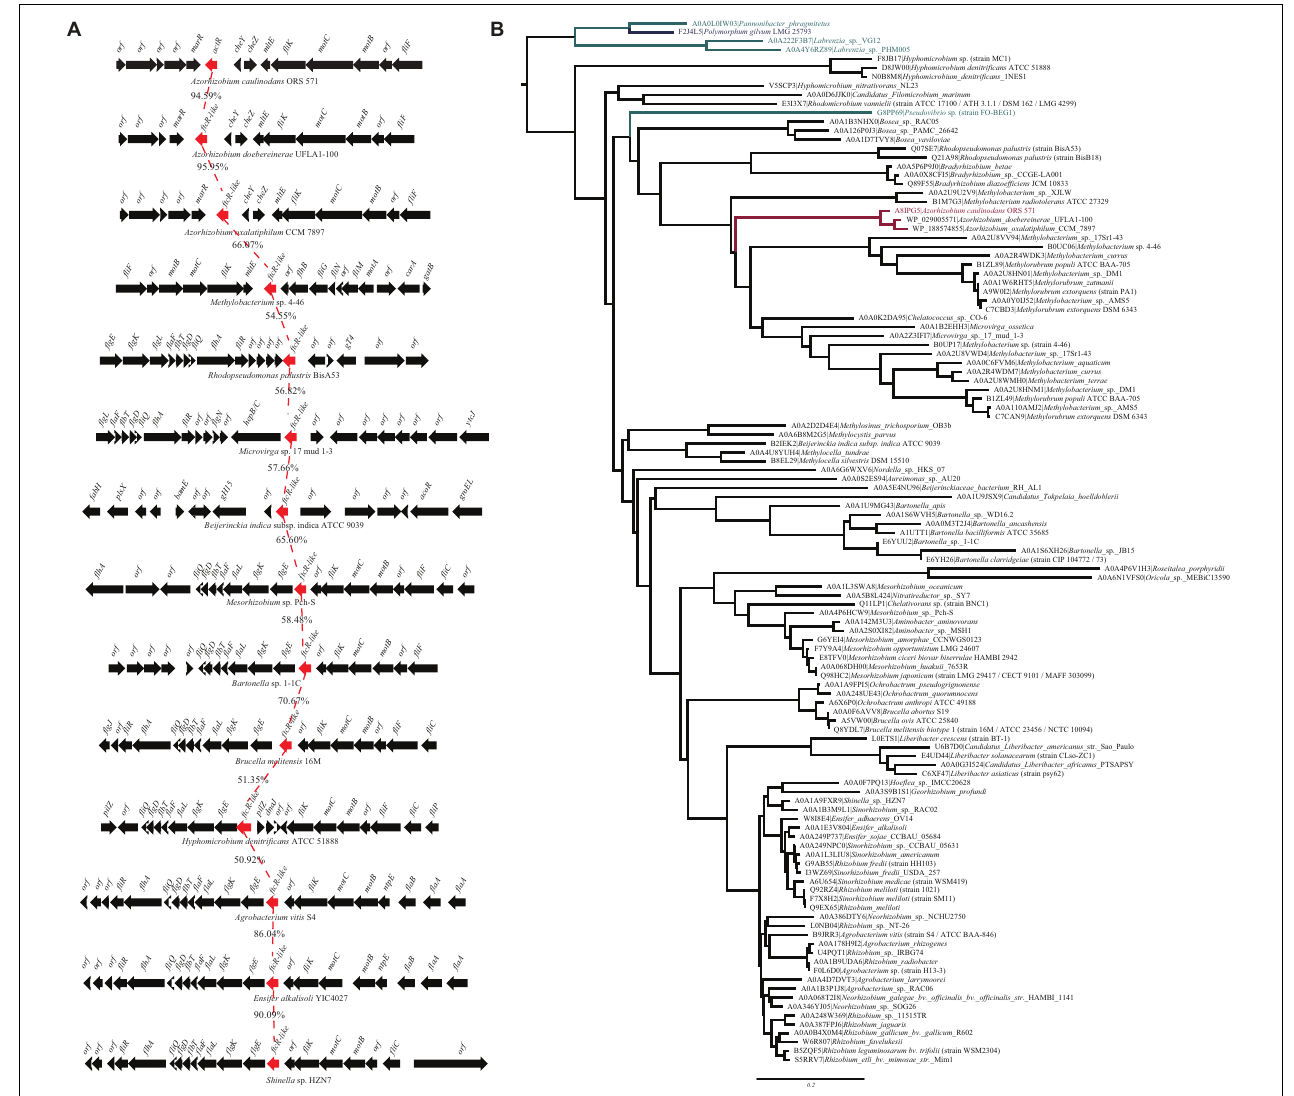
FIGURE 1 | (A) Genetic organization of gene clusters in the genomic region containing the ftcR . The frcR coding sequences (CDS) is indicated in red. Percentage amino acid identities of the FtcR are shown. (B) Maximum likelihood phylogeny of the protein sequences of FtcR homologs. The clades of the order Rhizobiales, Rhodobacterales, and Polymorphum are indicated in black, turquoise, and blue, respectively. The Azorhizobium clade and A8IPG5 (ActR; Azorhizobium caulinodans ORS571) are indicated in